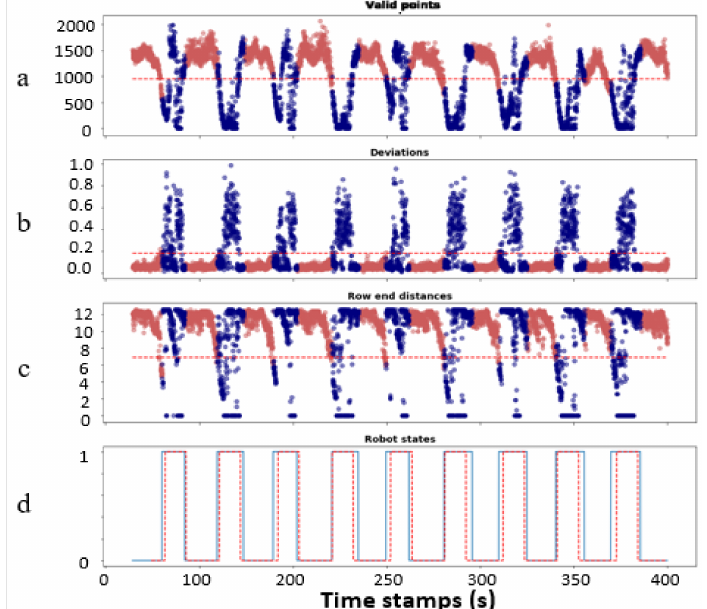
Figure 14. The number of valid points ( a ), yaw deviations in rads ( b ), and row-end distance in meters ( c ) over time while traversing the first 10 rows of the experiment, and ( d ) shows the state of the robot: “0” represents “IN ROW NAVIGATE,” and “1” represents “U_TURN_NAVIGATE”. The dashed red line is the ground truth—ideal case—state, and the solid blue line is the computed state during the